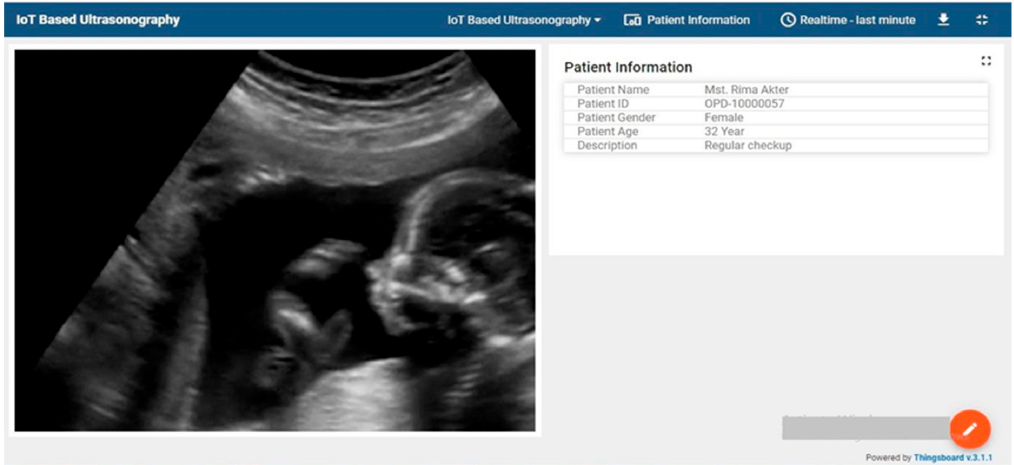
Figure 10. Ultrasound image view with patient information.